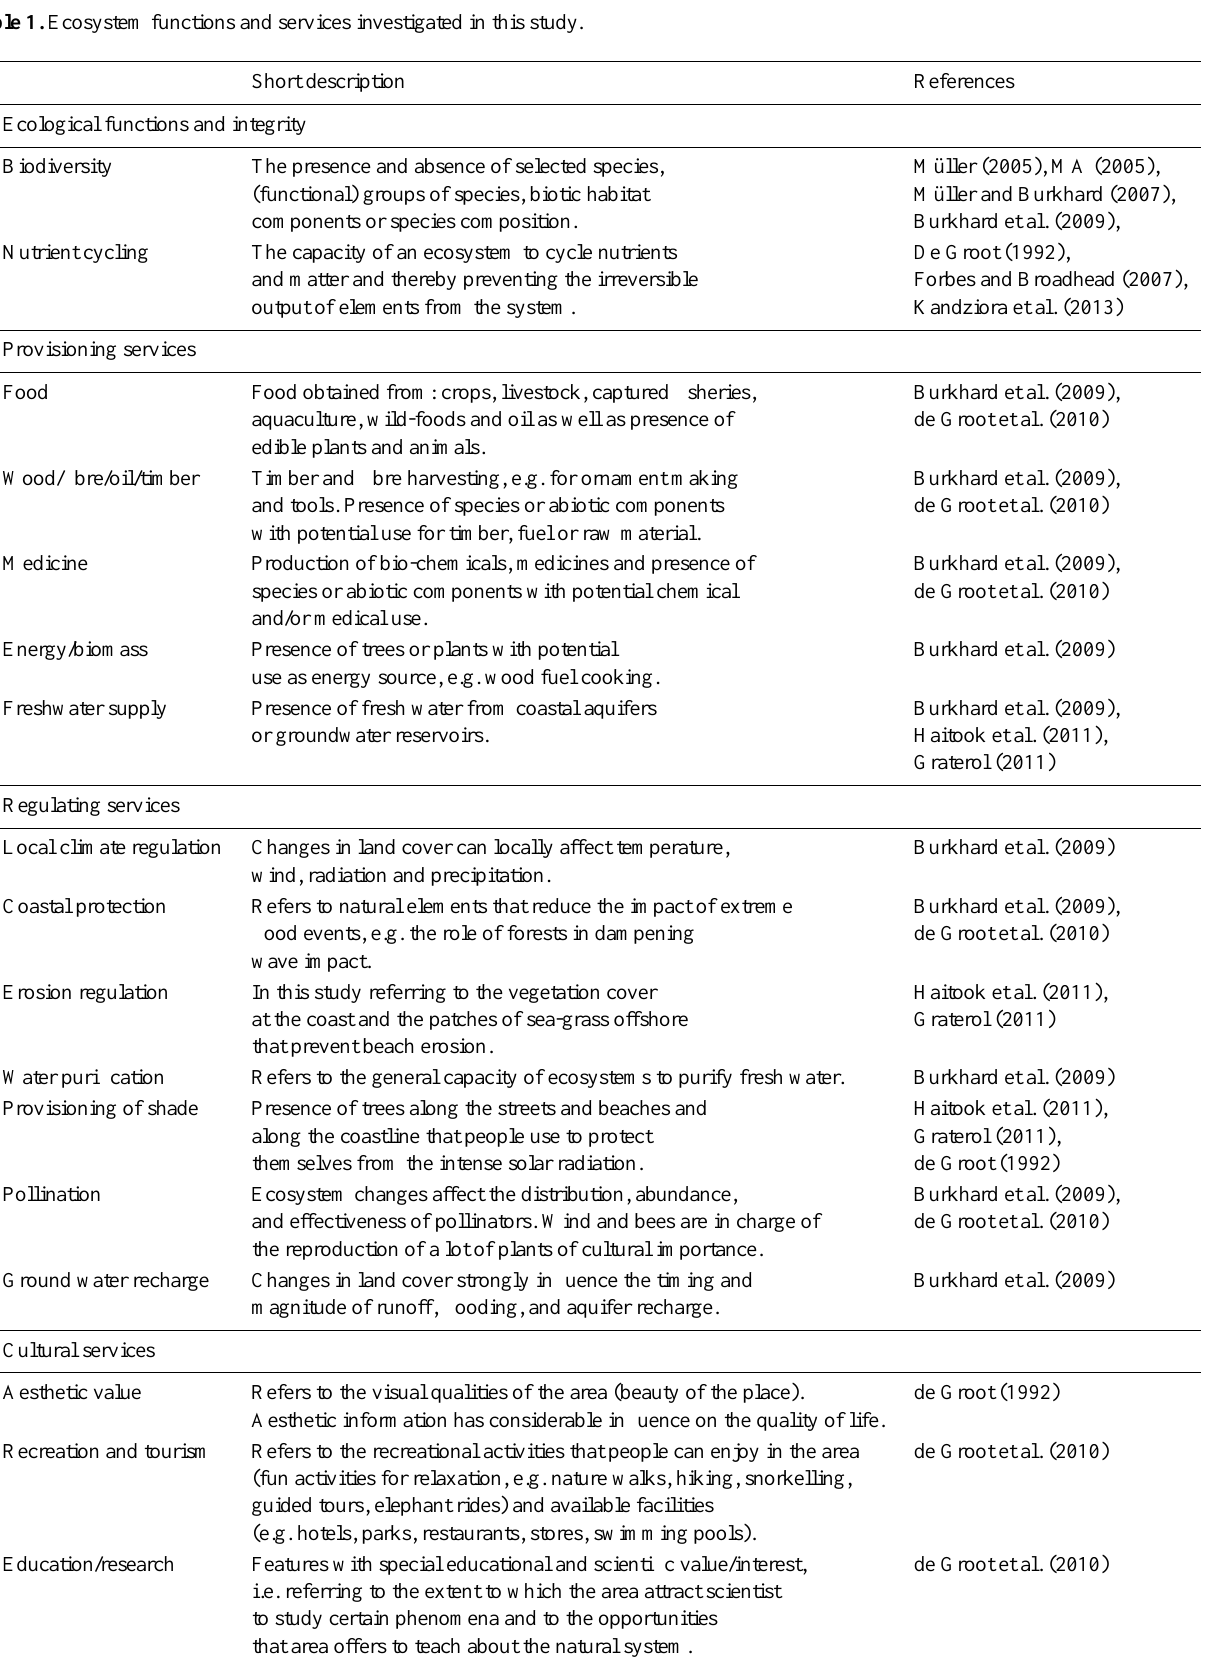
Table 1. Ecosystem functions and services investigated in this